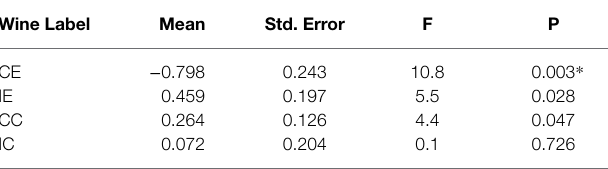
TABLE 6 | Mean of the PCN amplitudes for each bottle/label averaged across sessions from 240 to 280 ms, standard errors of the mean, and results of F tests as deviation from